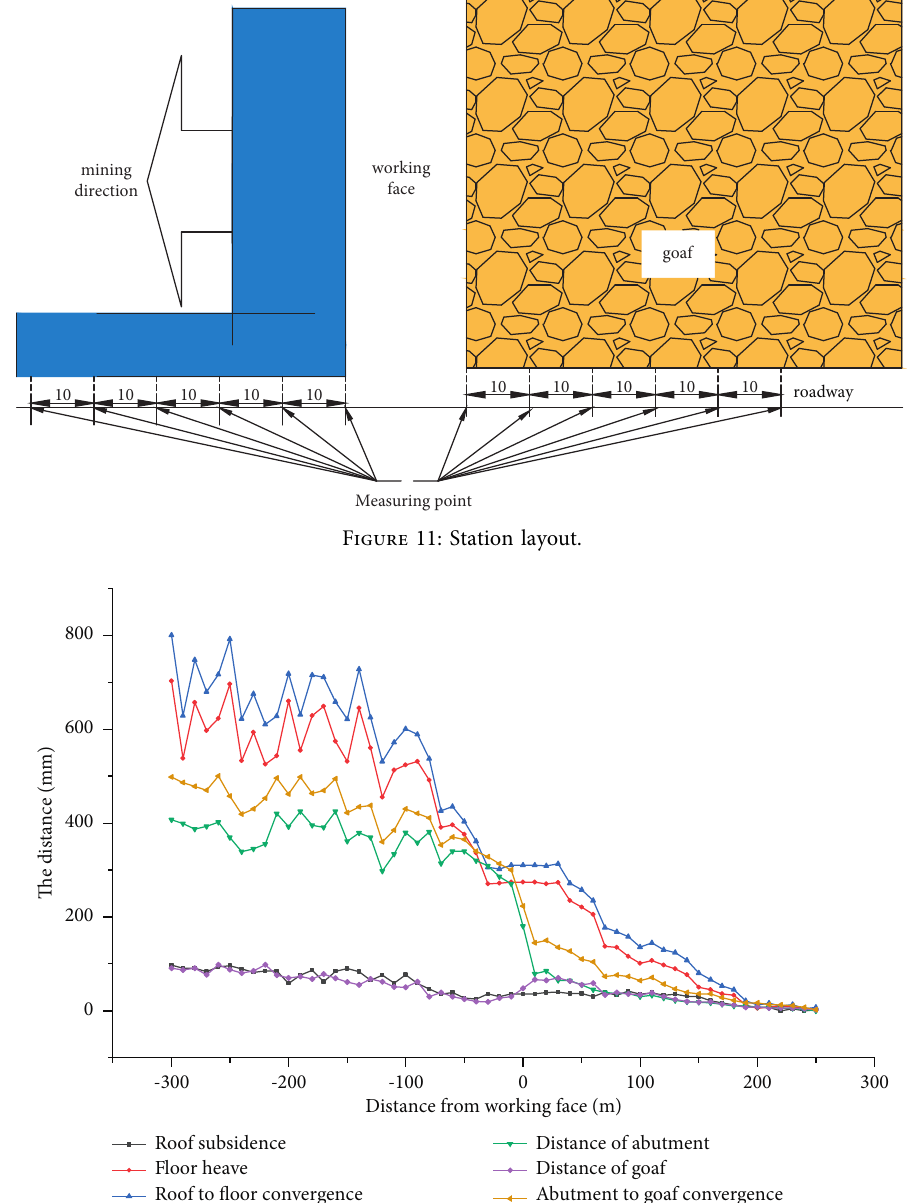
Figure 12: Deformation of the track crossheading of the 2013 working face.